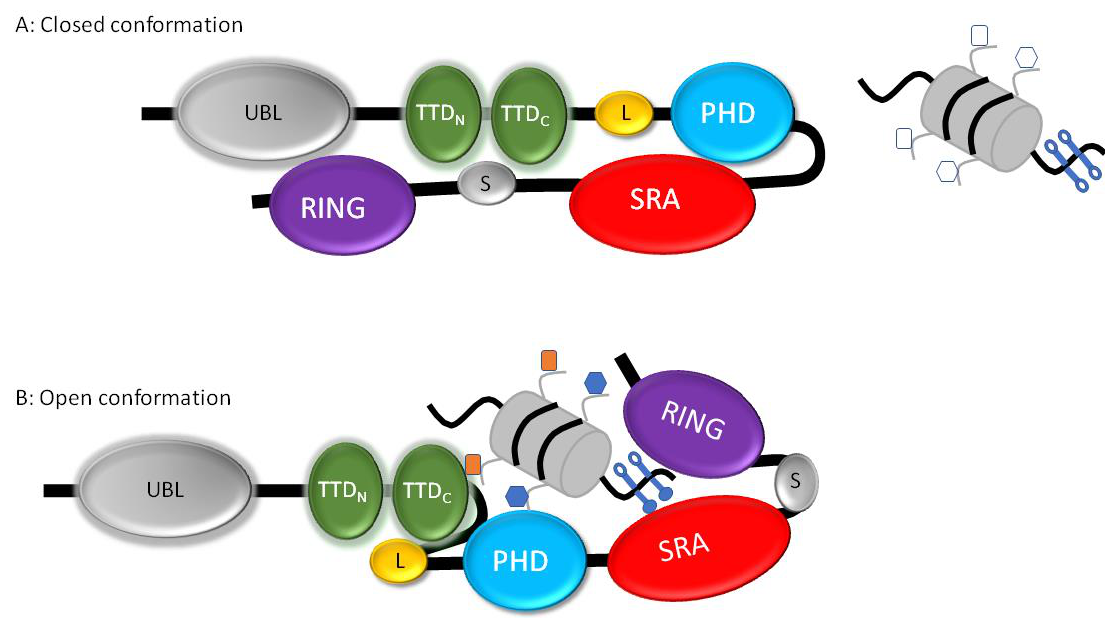
Figure 1. Schematic representation of ubiquitin-like containing plant homeodomain (PHD) and really interesting new gene (RING) finger domains 1 (UHRF1)’s domains with open and closed conformations. ( a ) Closed conformation of UHRF1. In the absence of methylated DNA (open lollipops), UHRF1 adopts a closed conformation with the spacer (S) facing the tandem Tudor domain (TTD) and the RING domain facing the ubiquitin-like domain (UBL). This interaction may represent a kind of auto-inhibitory mechanism as UBL exhibits analogy with ubiquitin. The SET- and RING-associated (SRA) domain faces the PHD domain. The linker (L) is the sequence between the TTD and PHD. ( b ) Open conformation of UHRF1. In the presence of hemi-methylated DNA (full lollipops on one strand) and in the presence of di/trimethylated lysine 9 on histone H3 (ocher rectangle on nucleosome) and of unmodified arginine 2 on histone H3 (blue hexagon on nucleosome), UHRF1 adopts an open conformation allowing each domain to fulfill its respective role. For instance, the RING domain can ubiquitinate histone H3 and the TTD with methylated histone